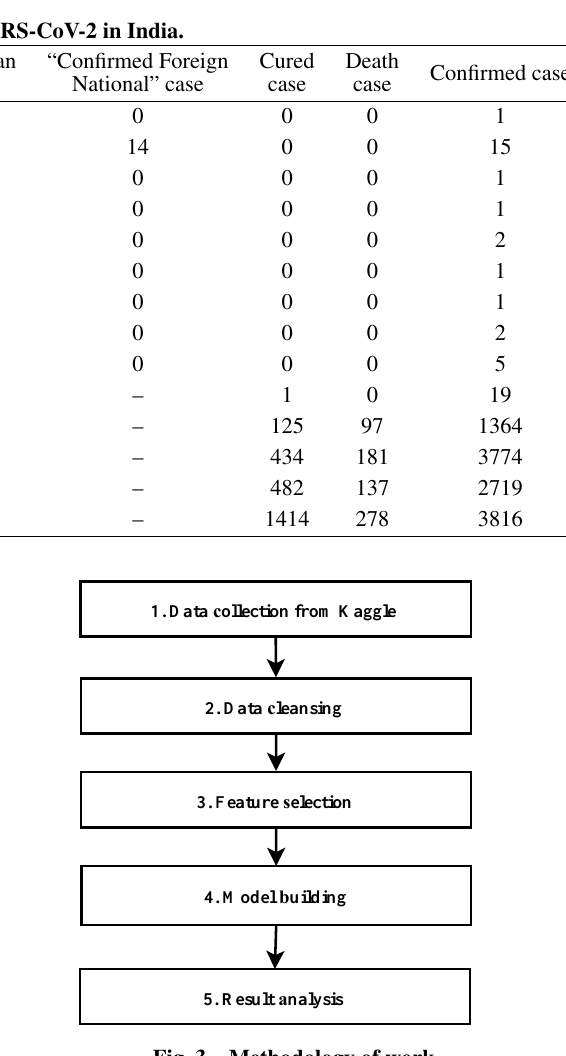
Fig. 3 Methodology of